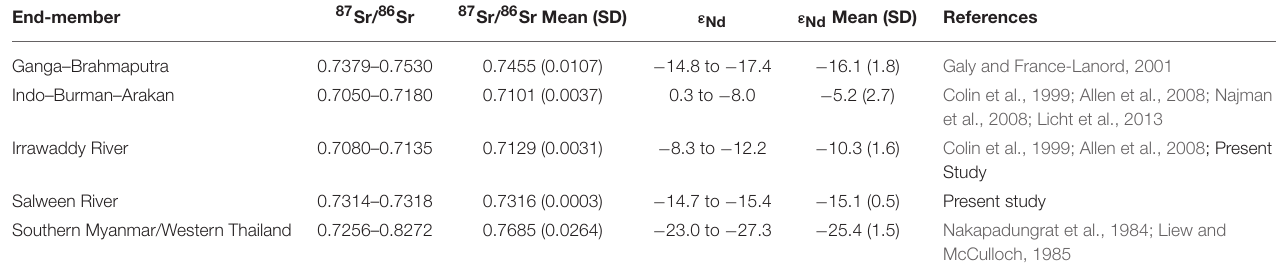
TABLE 2 | The end-members of Northern Andaman Shelf sediments, with their isotopic properties. End-member